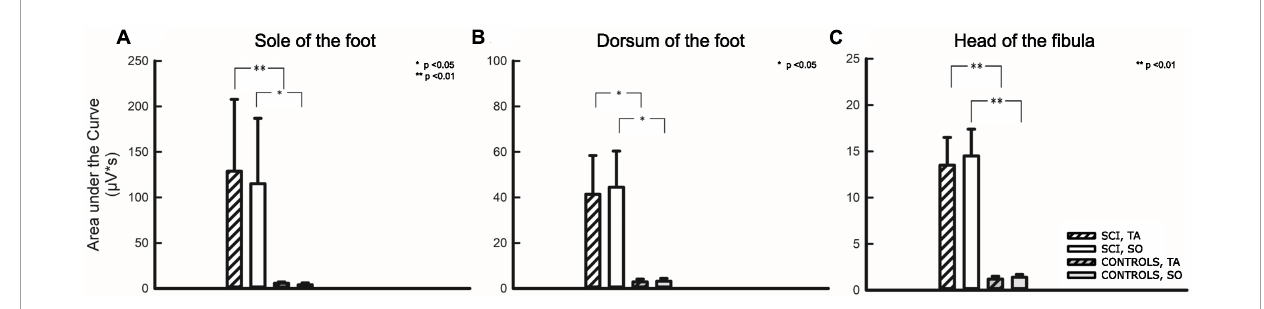
FIGURE5 Area under the curve analysis for three stimulation sites. Stimulation sites: (A) Sole of the foot, (B) Dorsum of the foot, (C) Head of the fibula. The first two bars on the left relate to participants with SCI, the two following bars relate to non-disabled controls. Hatched bars depict the area under the curve analysis of the tibialis anterior (TA), while uniformly filled bars depict the area under the curve analysis of the soleus (SO) muscle. Asterisks reflect significant differences in comparison between individuals with and without SCI at the respective sites and corresponding muscles. ∗ p < 0.05; ∗∗ p < 0.01.